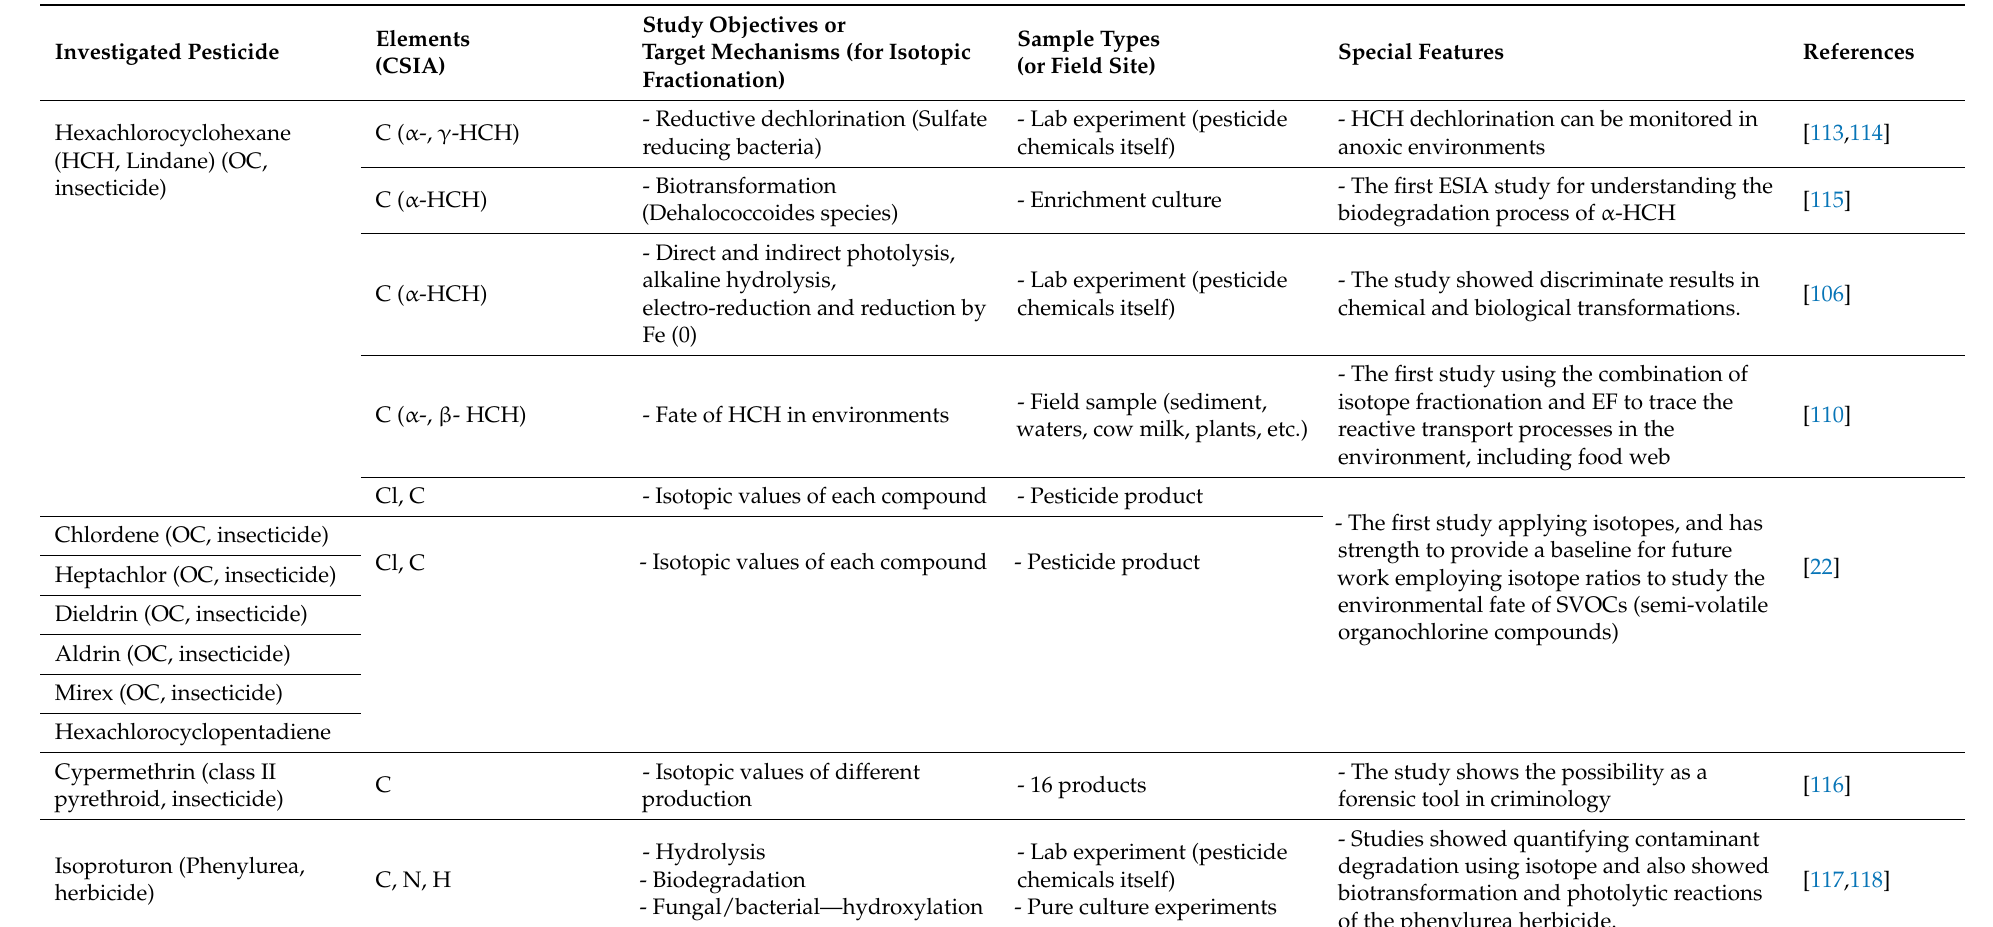
Table 2. Overview on CSIA studies conducted on pesticides (herbicide, fungicide, and insecticide). Almost all studies are from the last 20 years or so (since 2002). These are focused on natural abundances of isotopic compositions, except SIP. OC and OP indicated in the target pesticide list indicate organochlorine and organophosphate compounds,